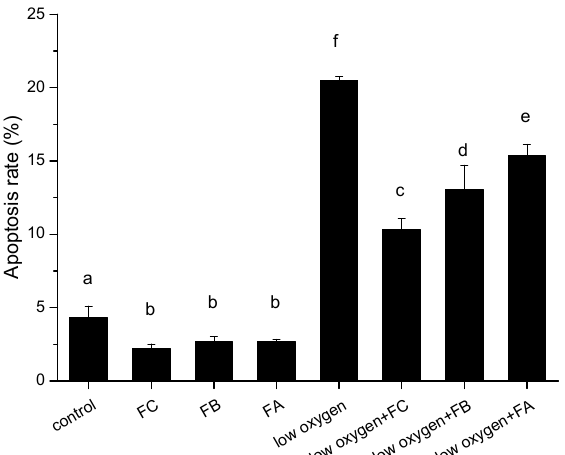
Figure 4. Hypoxia-induced apoptosis and the protective effect of three polysaccharide fractions after 24 h of treatment on PASM cells. Percentages reflect the total apoptotic cells (pre-apoptotic and apoptotic: quadrants two and four combined) pertreatment for means with different letters are significantly different from each other ( p < 0.05).